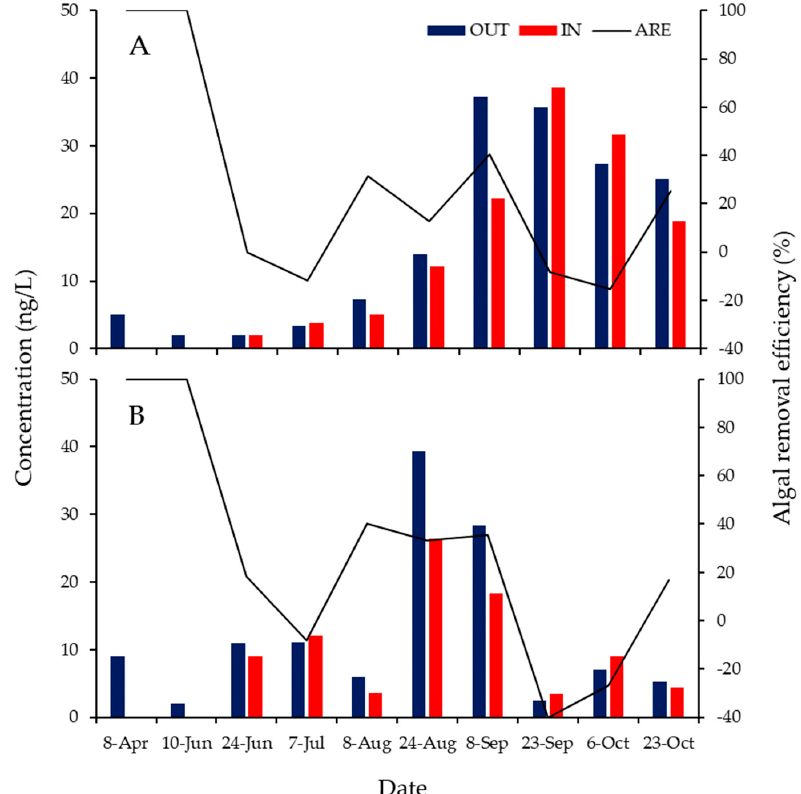
Figure 6. Variation in 2-methylisoborneol ( A ) and geosmin ( B ) concentration (ng/L) and algal removal efficiency (%) by an alternative algae-blocking mat from 8 April to 23 October 2015. Measurements were recorded using integrated water samples collected at different depths.